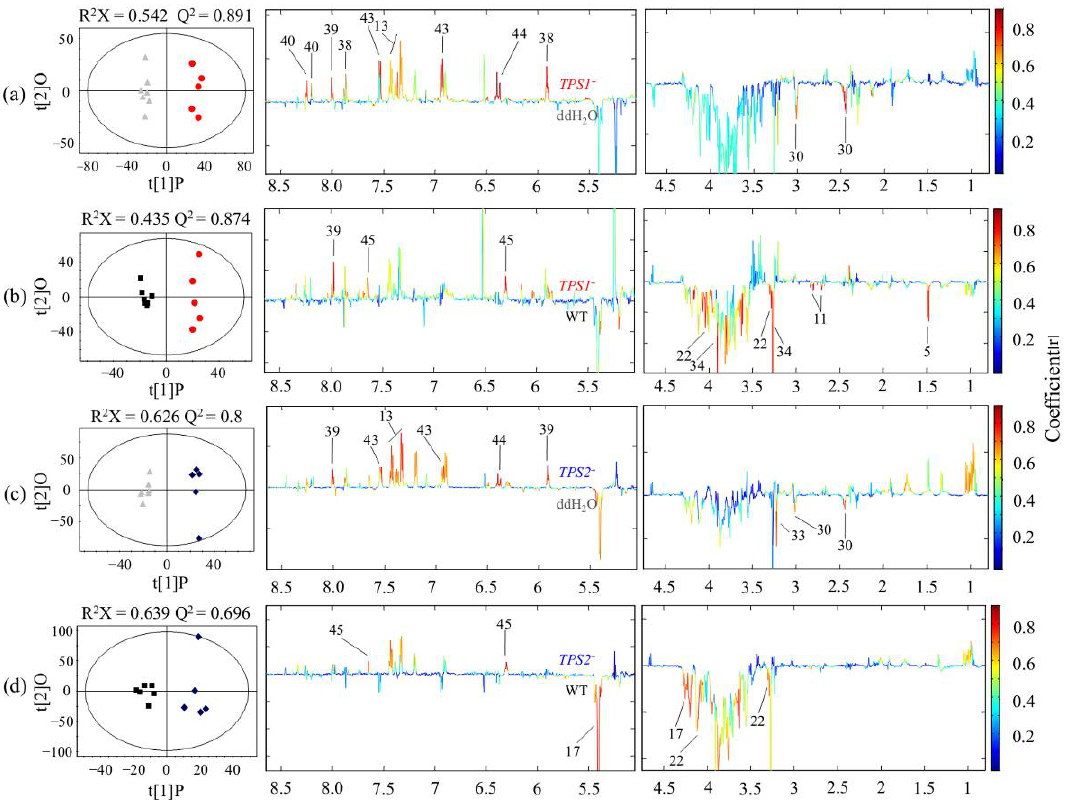
Figure 3. OPLS-DA scores plots ( left ) and coefficient-coded loadings plots ( right ) showing metabolic differences of FHB-resistant wheat Sumai 3 inoculated with ( a ) TPS1 − (red) vs. ddH 2 O (grey) (CV-ANOVA p = 0.0018), ( b ) TPS1 − (red) vs. WT (black) (CV-ANOVA p = 0.0029), ( c ) TPS2 − (blue) vs. ddH 2 O (grey) (CV-ANOVA p = 0.014), and ( d ) TPS2 − (blue) vs. WT (black) (CV-ANOVA p = 0.01). Metabolite keys are the same as in Figure 1 and Table S1.